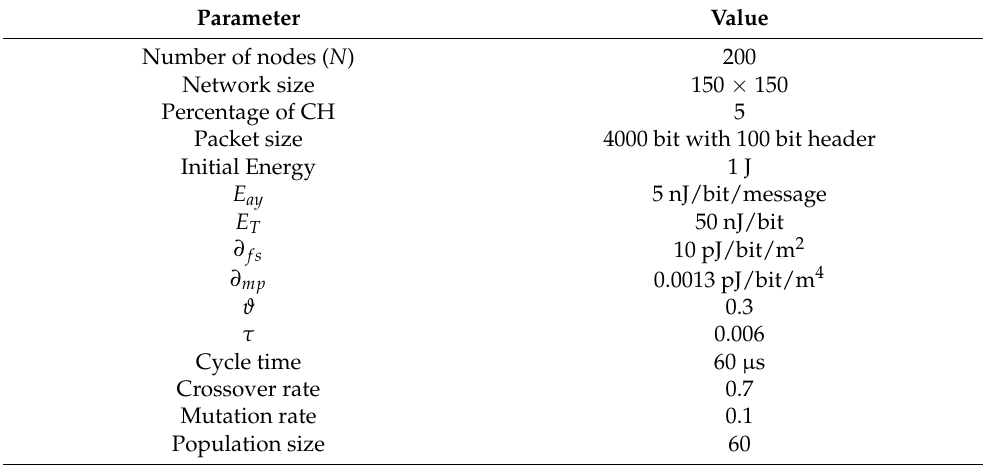
Table 3. Simulation